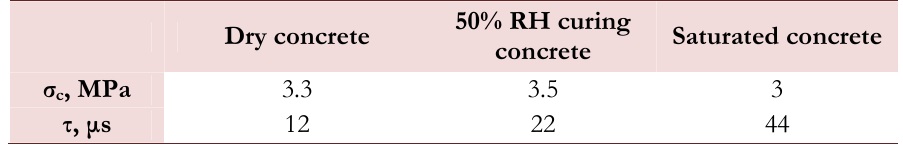
Table 2: Parameters of concrete at different curing